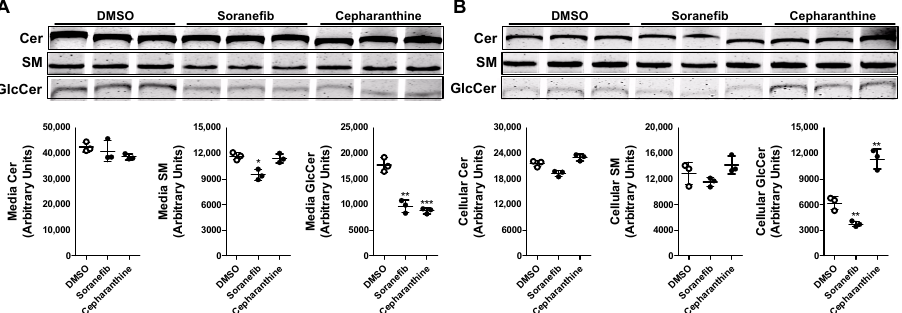
Figure 4. Pre-treatment of Huh-7 cells with ABCC10 inhibitors affects synthesis and efflux of GlcCer. Huh-7 cells were pre-treated with 5 µ M concentration of sorafenib or cepharanthine for 17 h, labeled with 2 µ M of C6-NBD ceramides in 10% FBS containing DMEM for another 3 h to study sphingolipid synthesis. Media were collected, and cells were washed three times with 0.1% BSA containing DMEM and then used to extract lipids. Sphingolipids were separated in the media ( A ) and cells ( B ) on TLC, and fluorescence in Cer, SM, and GlcCer bands was visualized with the PhosphorImager (top) and quantified using ImageJ software (bottom). Values are plotted as replicates (mean ± SD), * p < 0.05, ** p < 0.01 and *** p < 0.001 compared with DMSO-treated cells.